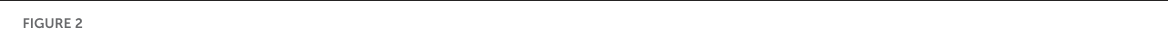
FIGURE2 borders when they were found for at least three block sizes (B) . Corresponding histological image of brain BC09 depicting the newly identified areas (C) . GLI profiles were calculated along traverses (numbered in red), representing cytoarchitecture changes from the border of layers I/II to the layer VI/white matter border. The observer-independent defined borders, corresponding to maxima of the MD function shown in (A) , are marked with black